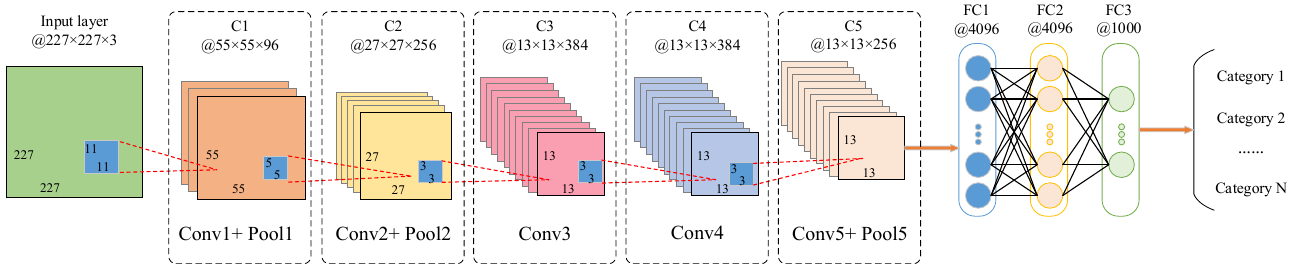
Figure 2. AlexNet network model structure